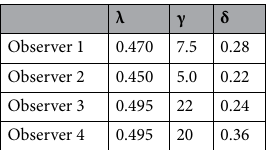
Table 1. SAT parameters of simulated